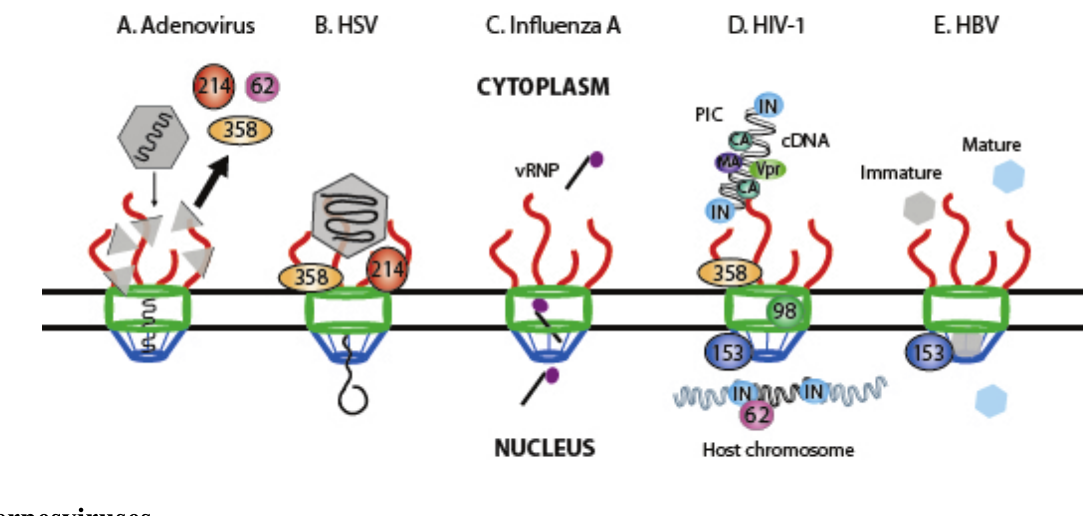
Figure 2. Viruses that hijack the nuclear pore complex to promote viral genome nuclear import. Schematic representations of the different mechanisms by which 5 viruses subvert various Nups in order to facilitate nuclear import. ( A ) Uncoating of the adenovirus capsid at the NPC causes at once the release of the DNA genome into the nucleus and displacement of Nup62, Nup214 and Nup358 into the cytoplasm. ( B ) HSV-1 capsid docking to cytoplasmic filaments leads to uncoating and driving the DNA genome through the NPC. ( C ) Import of the influenza A virus vRNP is mediated by the classical importin α / β transport pathway. ( D ) The HIV-1 PIC (pre-integration complex) docks to Nup358 before being imported into the nucleus and integrated into the host chromosome in the process that is facilitated by Nup62, Nup98 and Nup153. ( E ) Mature and immature HBV capsids are imported intact through the NPC, however; Nup153 ensures that only mature capsids disintegrate to release the DNA genome into the